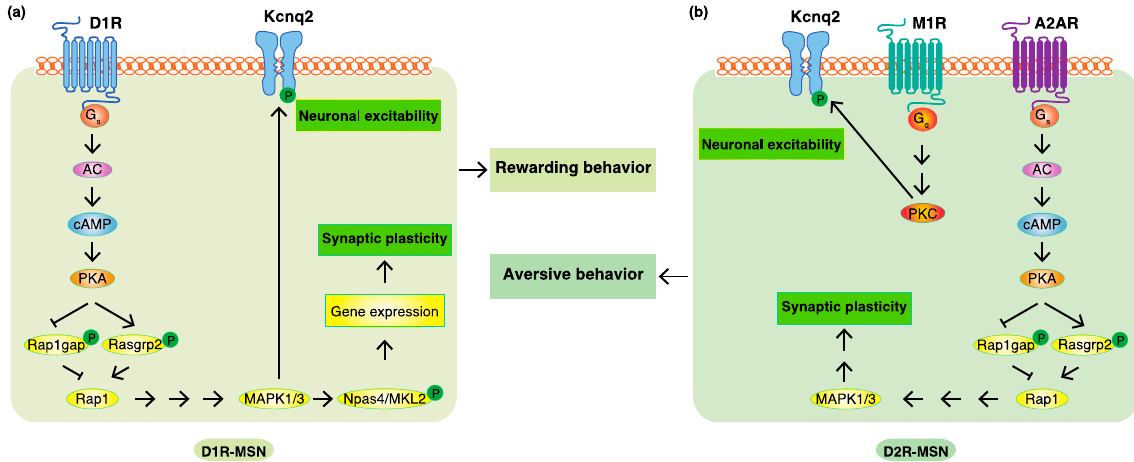
Figure 3. Phosphoproteomic analyses revealed new phosphorylation signals downstream of dopa- mine receptors in emotional behaviors. ( a ) In D1R-MSN, the stimulation of D1R by dopamine in- creased intracellular cAMP concentrations through AC, and this is followed by the activation of PKA. PKA phosphorylates Rasgrp2 and Rap1gap to induce the activation of Rap1, which promotes the MAPK pathway. MAPK phosphorylates Kcnq2 to increase membrane excitability and phos- phorylates Npas4 and MKL2 to facilitate the expression of the genes accounting for synaptic plas- ticity, consequently leading to rewarding behavior. ( b ) In D2R-MSN, a decreased dopamine con- centration cancels the suppressive effects of D2R. The stimulation of A2AR without the inhibition of D2R increases intracellular cAMP concentrations through AC, and this is followed by the activa- tion of PKA. PKA phosphorylates Rasgrp2 and Rap1gap to induce the activation of Rap1, which promotes the MAPK pathway involved in synaptic plasticity. Acetylcholine/M1R signaling acti- vates PKC to promote the phosphorylation of Kcnq2, which is involved in membrane excitability. These changes consequently lead to aversive behavior. D1R, dopamine D1 receptor; MSN, medium spiny neuron; Gs, stimulatory G protein; AC, adenylate cyclase; cAMP, cyclic adenosine monophos- phate; PKA, protein kinase A; Rap1gap, rap1 GTPase-activating protein; Rasgrp2, Ras guanyl re- leasing protein 2; MAPK1/3, mitogen-activated protein kinase 1/3; Npas4, neuronal Per Arnt Sim domain protein 4; MKL2, megakaryoblastic leukemia-2; M1R, muscarinic M1 receptor; A2AR, aden- osine A2A receptor; Gq, Gq protein; PKC, protein kinase C; Kcnq2, potassium voltage-gated channel subfamily Q member 2; P, Phosphate.